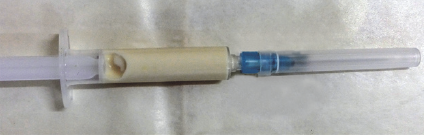
Figure 2: A milky fluid was aspirated with fine needle aspiration of the axillary mass.